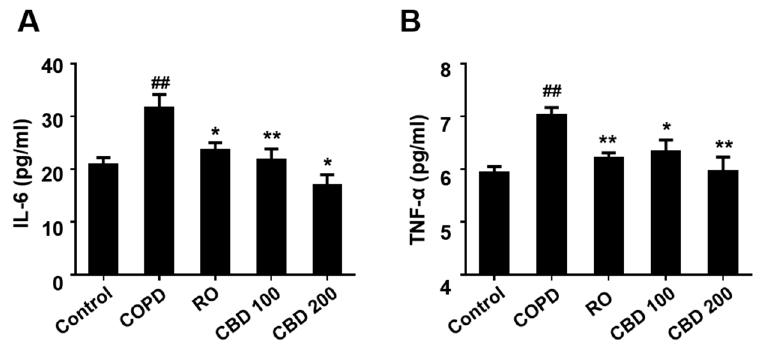
Figure 3. Effects of CBD on concentrations of proinflammatory cytokines in BALF. Individual sam ‐ ples were analyzed using ELISA. ( A ) IL ‐ 6. ( B ) TNF ‐α . Control: mice instilled intratracheally